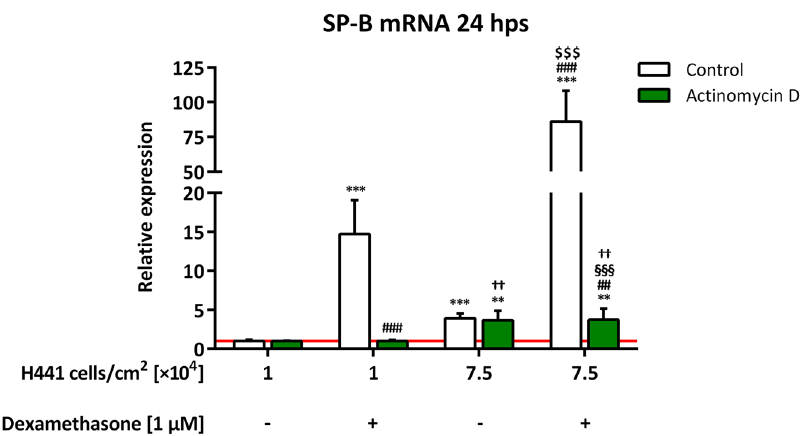
Fig 7. Influence of cell density on SP-B mRNA stability in H441 cells. Different quantitiesof H441 cells were seeded as indicatedand either left untreated or incubatedwith 1 μ M dexamethasone and/or 10 μ g/mL actinomycin D for 24 h. SP-B mRNA levels were normalized to β -actin and fold differences comparedto 1 × 10 4 untreated cells per cm 2 were calculatedfor each group. Means +SD of n = 4 experiments are shown. Statistical analyseswere performed using Student’s unpaired t test and only relevant significances are shown. ** p < 0.01 and *** p < 0.001 comparedto 1 × 10 4 untreated cells per cm 2 , ## p < 0.01 and ### p <